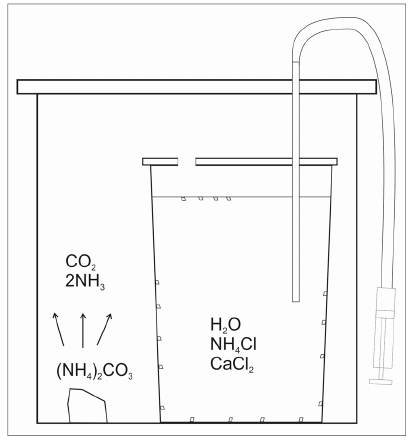
Figure 1. Experimental schematics.